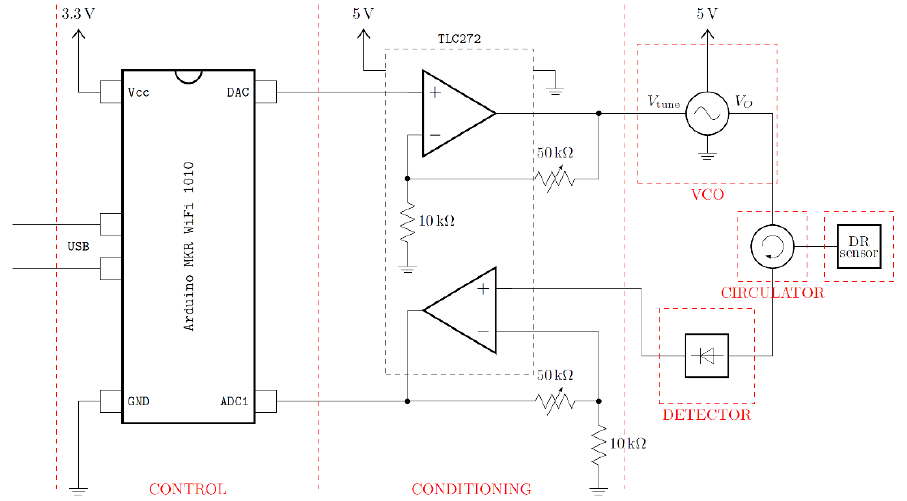
Figure 4. Electric circuit diagram of the electronic reader with all the components involved in the signal acquisition. This design is divided into three parts: control, conditioning, and MW sensing.